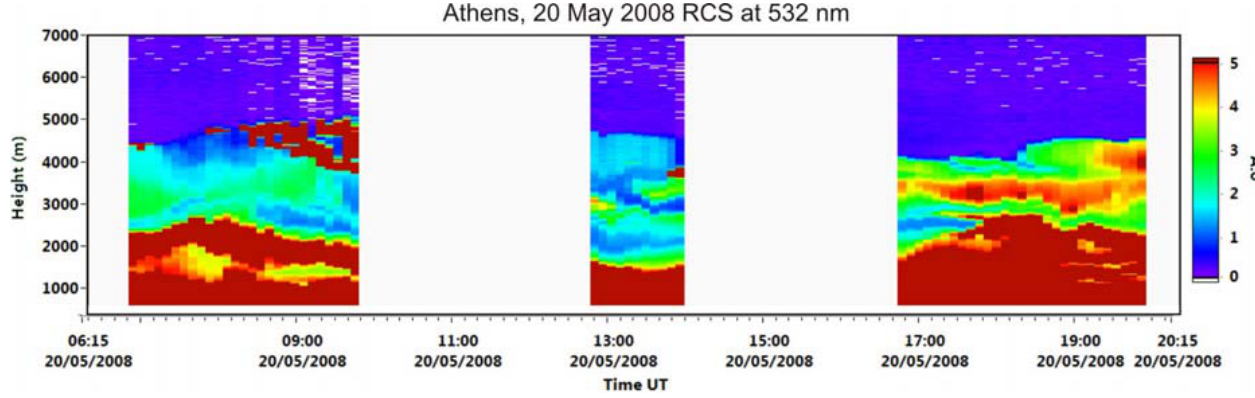
Fig. 5. Time-height cross section of the lidar range corrected signal at 532 nm (arbitrary units) measured on 20 May 2008 over Athens.